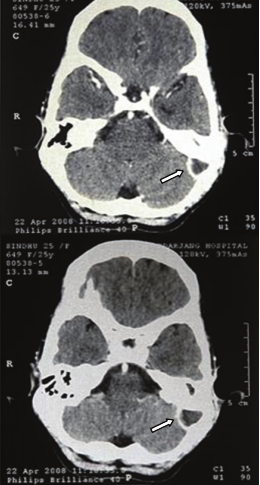
Figure 2: CT scan showing lateral sinus thrombosis.